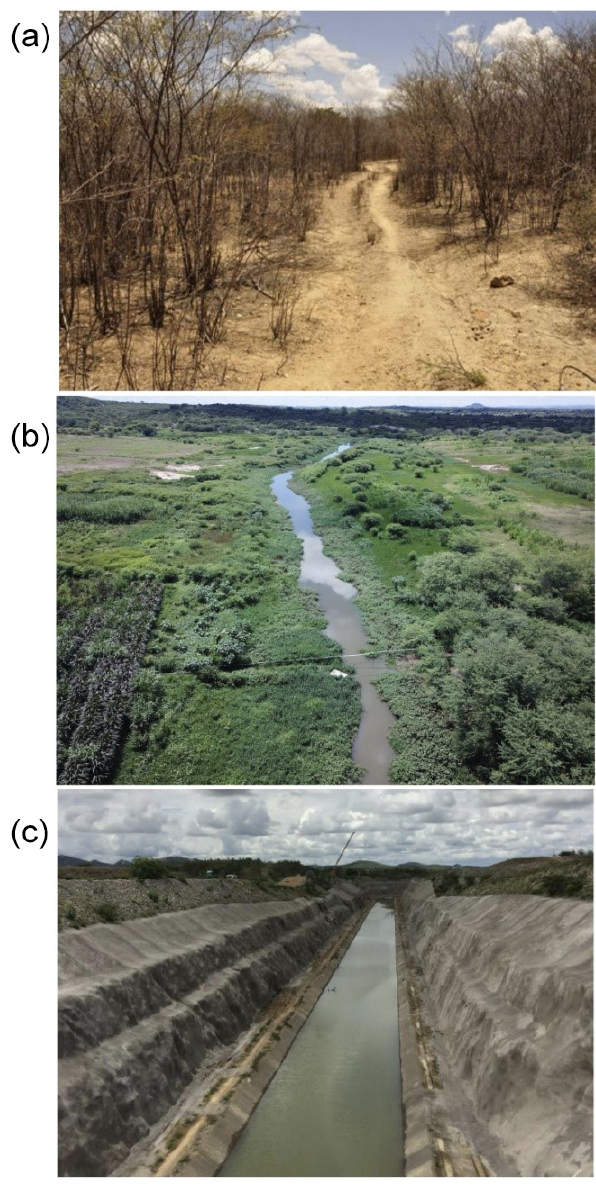
Figure 1. A perspective of the Caatinga forest during the dry season at the ground level (a) . A perspective of land use in the Caatinga biome during the wet season at the landscape level (b) . An example of human intervention affecting the river course that has an impact on water availability across the region (c)